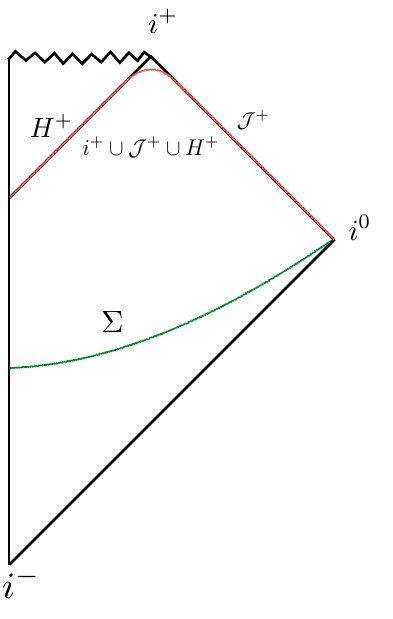
Figure 3 . For a black hole formed by gravitational collapse, components of the boundary are J − , J + , H + and the points at infinity i − , i 0 , and i + . Since the first variation of global charges is invariant under local deformations of the Cauchy surface Σ , one can deform Σ to J + ∪ i + ∪ H + in the far future. Then, δQ ξ (Σ) = δQ ξ ( J + ) + δQ ξ ( i + ) + δQ ξ ( H + ) . With our boundary conditions δQ ξ ( i + ) = 0